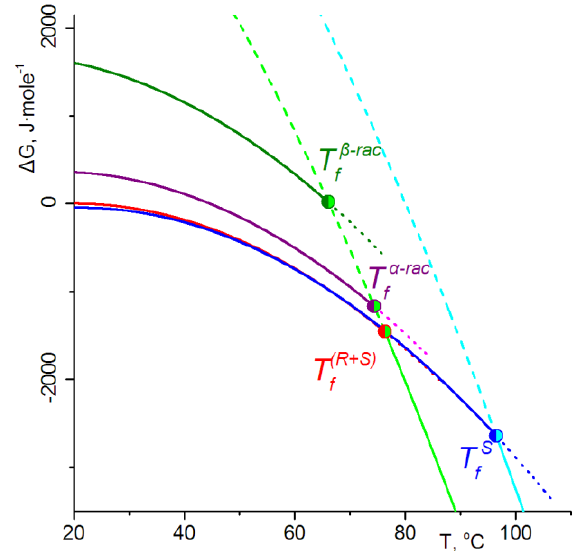
Figure 4. The temperature dependence of the Gibbs free energy change for the enantiopure sample ( R )- 1 (blue line), racemic conglomerate ( R + S )- 1 (red line), α - rac - 1 (violet line), β - rac - 1 (olive line), racemic melt (green line), and single enantiomeric melt (cyan line). Dashed lines correspond to the metastable supercooled state of melts; dot lines correspond to extrapolations of the free energies of crystalline phases in the temperature range above their melting temperature.